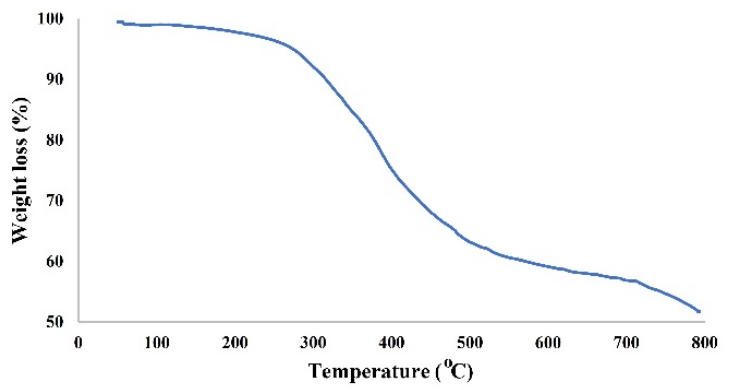
Figure 4. TGA curve of SPION@CS − IL catalyst.